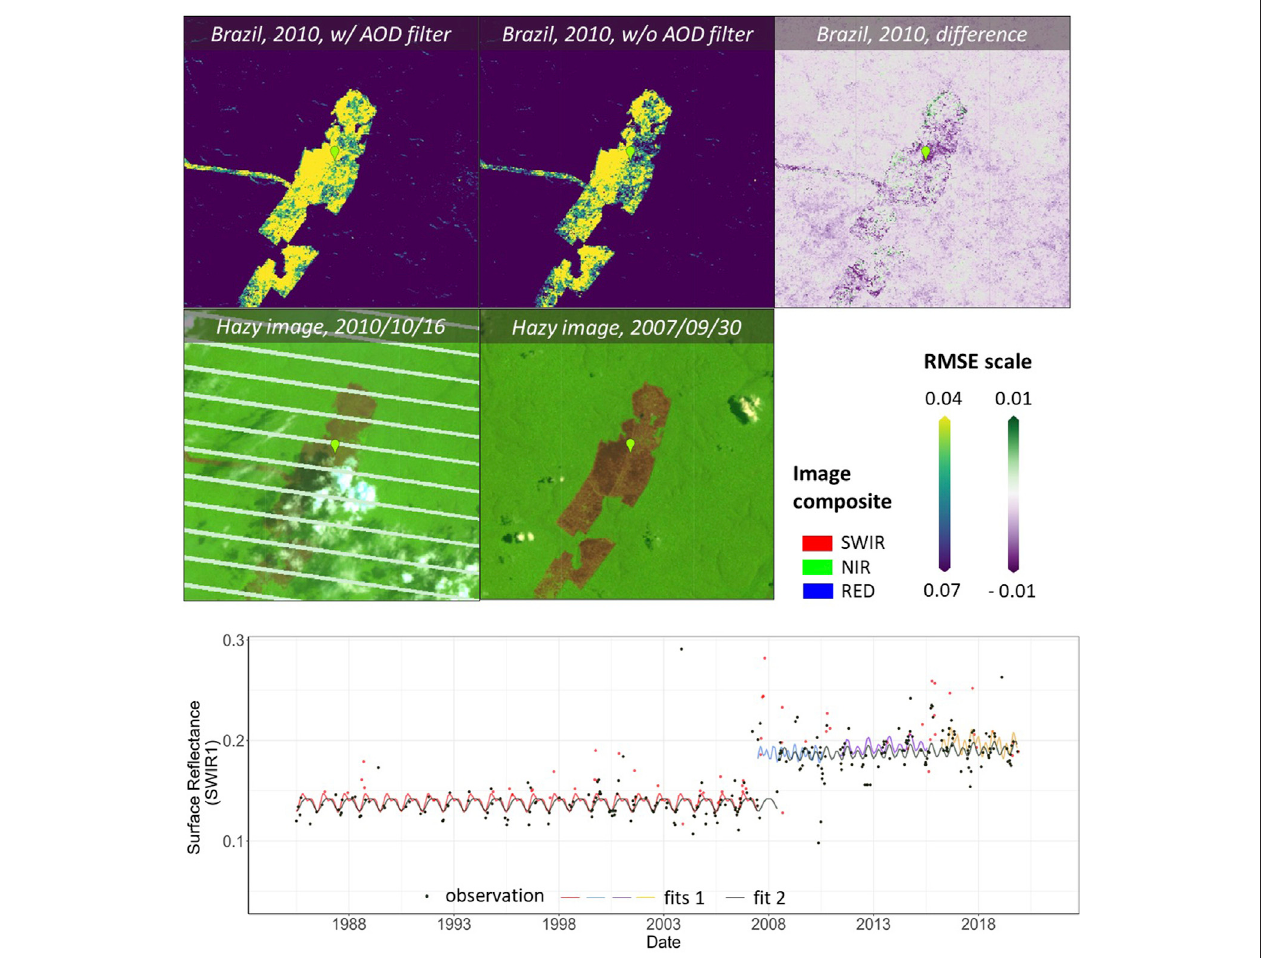
FIGURE 7 | The fi rst row is the Root Mean Square Error (RMSE) map of the CCDC model for 2010 near the Amazon Forest. From the left to right, they are RMSE maps withAOT fi lter,withoutAOT fi lter,and thedifference betweenusingAOT fi lterornot.ThetwoimagechipsareLandsatimageries onspeci fi cdates.Thetimeseries plot includes twocases: black dots and black curves correspond toCCDC model fi tsusing AOT fi lter; red dots and red/blue/purple/yellow curves correspondto CCDC model fi ts without using AOT fi lter (Lat: − 5.7818; Lon: − 59.8746).